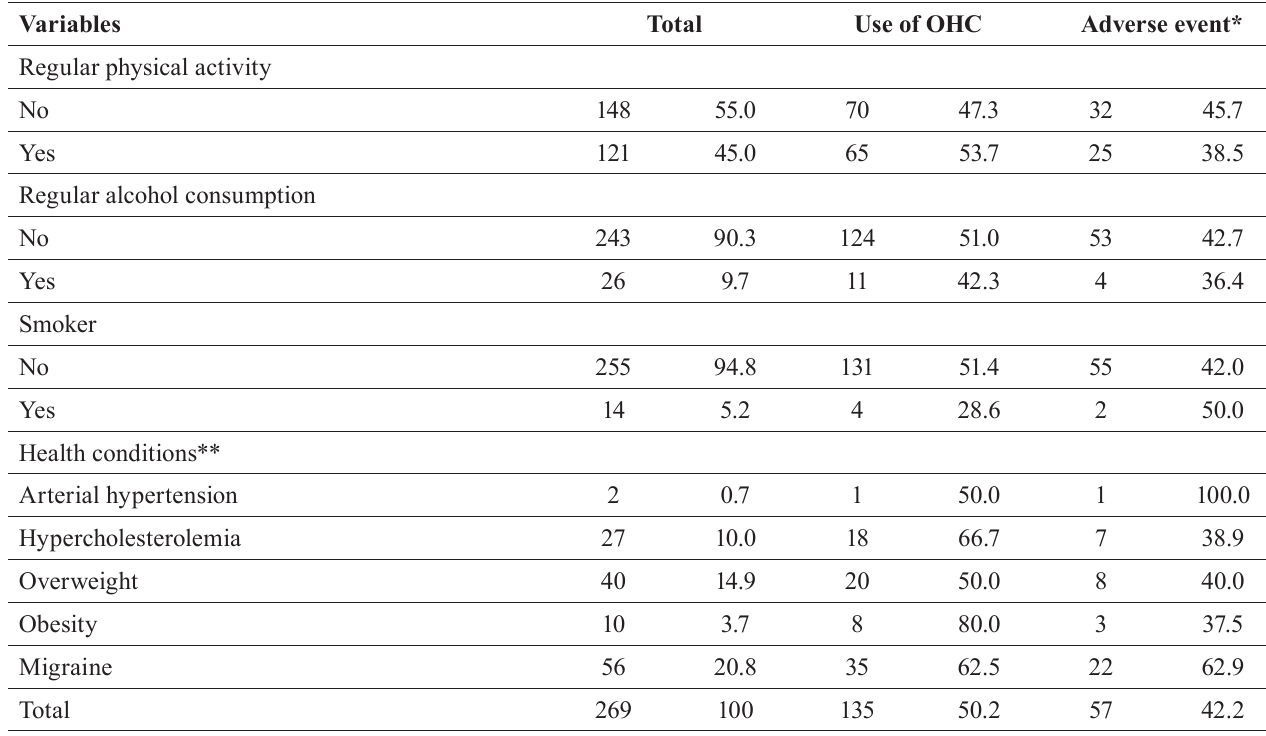
TABLE I - C haracteristics of pharmacy students (n = 269) Variables